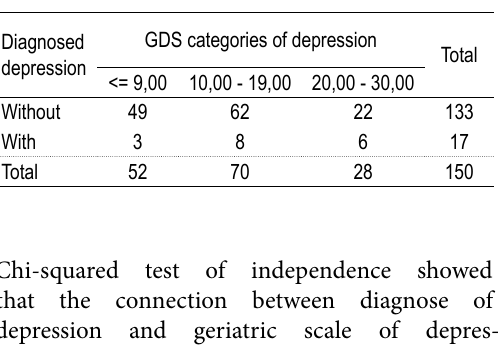
TablE 2. rate of verified diagnose of depression and un - known depression according to